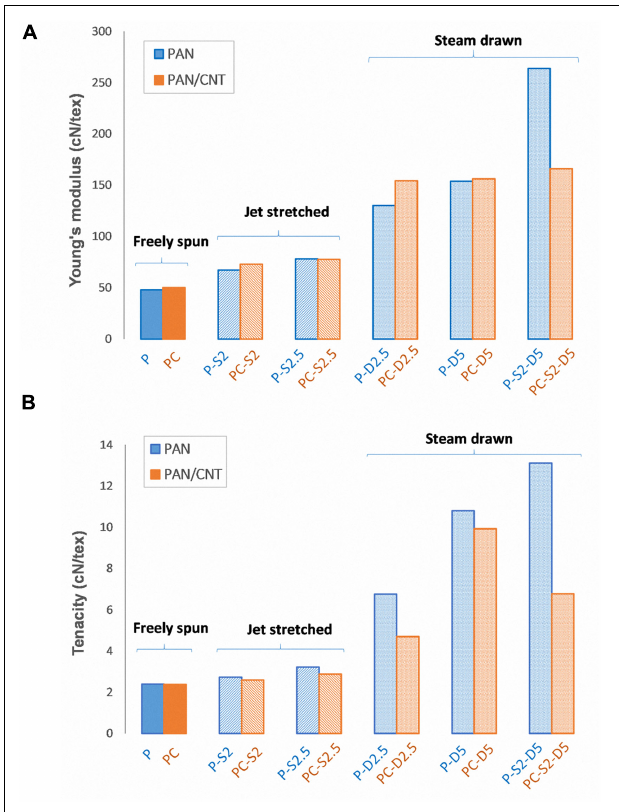
FIGURE 8 | Mechanical properties of PAN/CNT and PAN fibers at different stretching conditions, (A) Young’s modulus, (B) Tenacity.